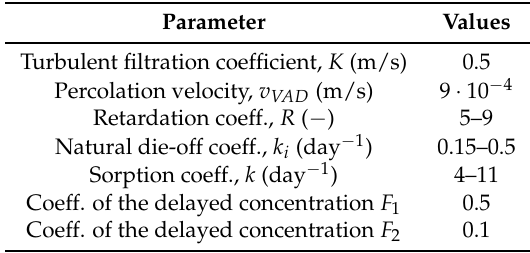
Table 5. Values of variational and fixed parameters after the sensitivity analysis.